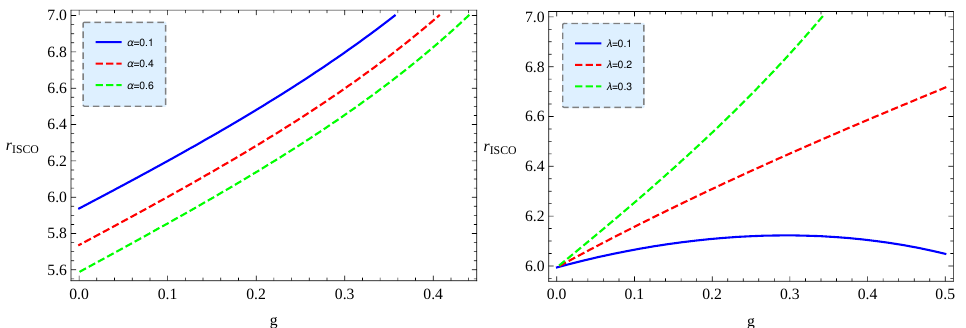
Figure 10. Innermost stable orbits dependence on magnetic charge parameter of the black hole g for different values of α , while fixing λ = 0.3 ( left panel) and for different values of λ , while fixing α = 0.01 ( right